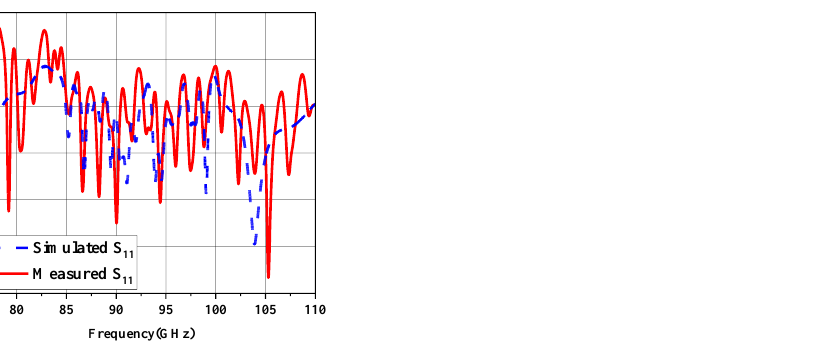
Figure 10. The simulated and measured reflection coefficient of the proposed array antenna. The simulated and measured radiation patterns at 80 GHz, 94 GHz and 100 GHz are shown in Figure 11. It can be seen that the simulated and measured results are in good agreement. The realized beam tilt-angles at 80 GHz, 94 GHz and 100 GHz are 36 ◦ , 33 ◦ and 31 ◦ , respectively. The gain and beam-tilted angle of proposed antenna are shown in Figure 12, the minimum antenna gain is 11.5 dBi and the maximum gain is 16.8 dBi, the fluctuation of beam-tilted is less than 4 ◦ compared with expected 35 ◦ . Possibly due to the machining tolerance, assembling or measuring errors, the measured gain is slightly lower than simulated but within the allowable margin of error. Overall speaking, although the excitation distribution is calculated at 94 GHz, the beam tilt- angle is around 35 ◦ over the whole working frequency band. This implies that the beam tilt angle has high tolerance for excitation distribution, but it also runs the risk of loss of gain.